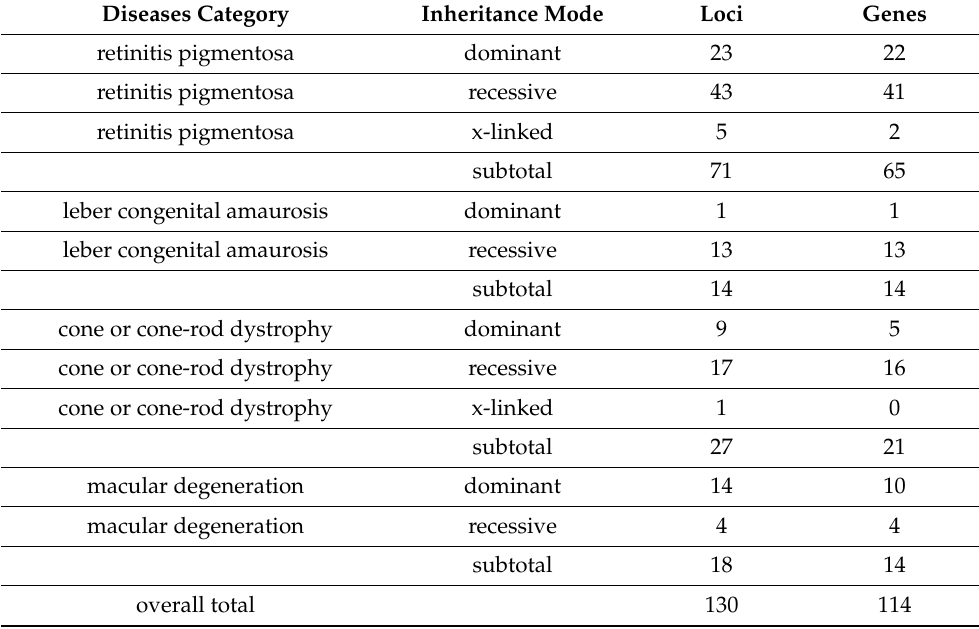
Table 1. Genetic loci and number of genes, with their inheritance mode, for disease categories Retinitis Pigmentosa (RP), Leber Congenital Amaurosis (LCA), Cone or Cone-Rod Dystrophy (CORD), and Macular Degeneration (MD) from the RetNet database (https://sph.uth.edu/RETNET/sum-dis.htm, accessed on 15 February 2021).